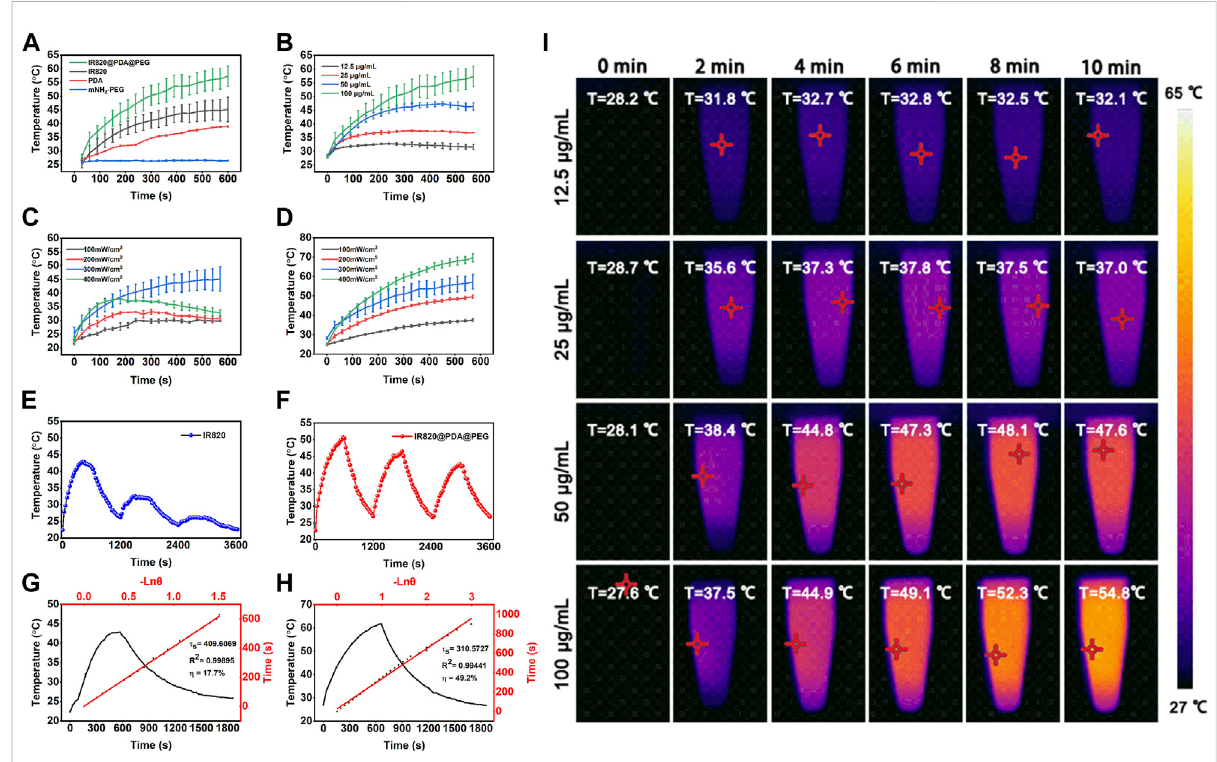
FIGURE 4 Photothermal property evaluation of IR820@PDA@PEG NPs. (A) Temperature curves of free IR820, mPEG-NH 2 , PDA and IR820@PDA@PEG NPs (100 μ g/ml, 300 mW/cm 2 ). (B) Temperature curves of IR820@PDA@PEG NPs at different concentrations (12.5, 25, 50, and 100 μ g/ml). (C) Temperature curves of free IR820 under 793 nm laser irradiation with different power densities (100, 200, 300, and 400 mW/cm 2 ). (D) Temperature curves of IR820@PDA@PEG NPs under 793 nm laser irradiation with different power densities (100, 200, 300, and 400 mW/cm 2 ). (E) Photothermal stability of free IR820 during three heating-cooling cycles (100 μ g/ml, 300 mW/cm 2 ). (F) Photothermal stability of IR820@PDA@PEG NPs during three heating-cooling cycles 300 μ g/ml, 100 mW/cm 2 ). (G) Photothermal conversion ef fi ciency of free IR820 (100 μ g/ml, 300